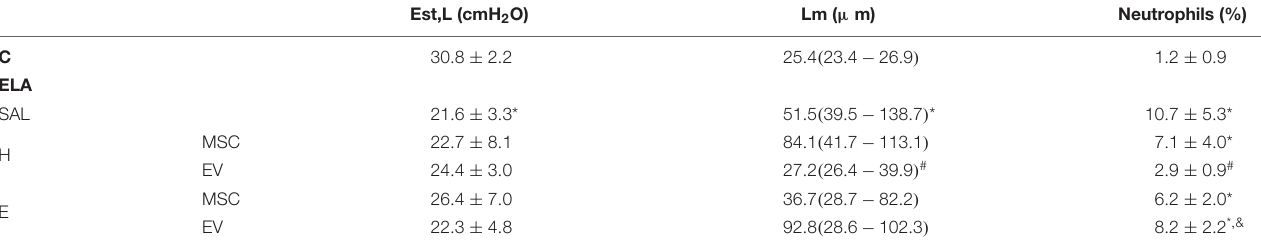
TABLE 1 | Lung mechanics and